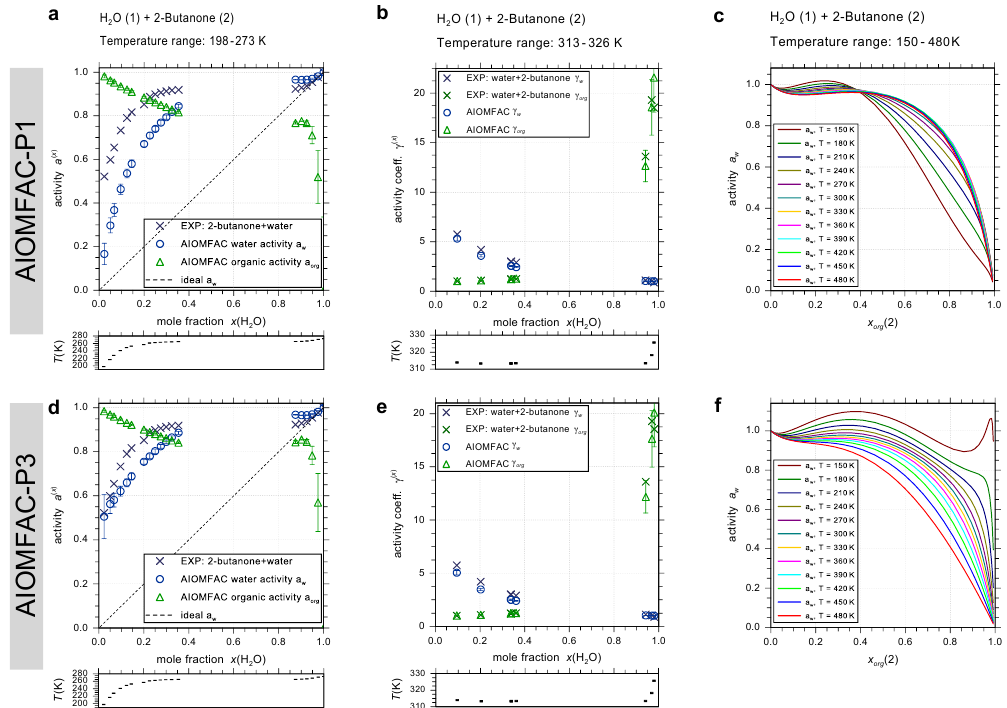
Figure 5. SLE and VLE measurements for water (1) + 2-butanone (2) solutions and corresponding calculations of AIOMFAC-P1 (a–c) or AIOMFAC-P3 (d–f) . Panels (c, f) show the temperature dependence of water activities predicted for the range 150–480K. (a, d) Low temperature experimental SLE data (crosses) are compared with the predictions for water activity at the same compositions and temperatures (blue circles). Predictions of the corresponding organic activities are shown as well (green triangles). The error bars represent the model sensitivity to a composition variation by x tol = 0 . 01. The dashed line represents the hypothetical water activity of an ideal mixture. Panels (b, e) show the model predictions of the activity coefficients compared to VLE data covering temperatures significantly higher than room temperature. The temperatures of the individual data points are given in the boxes below the main panels. Experimental data: Lohmann et al. (1997) and Gmehling et al.